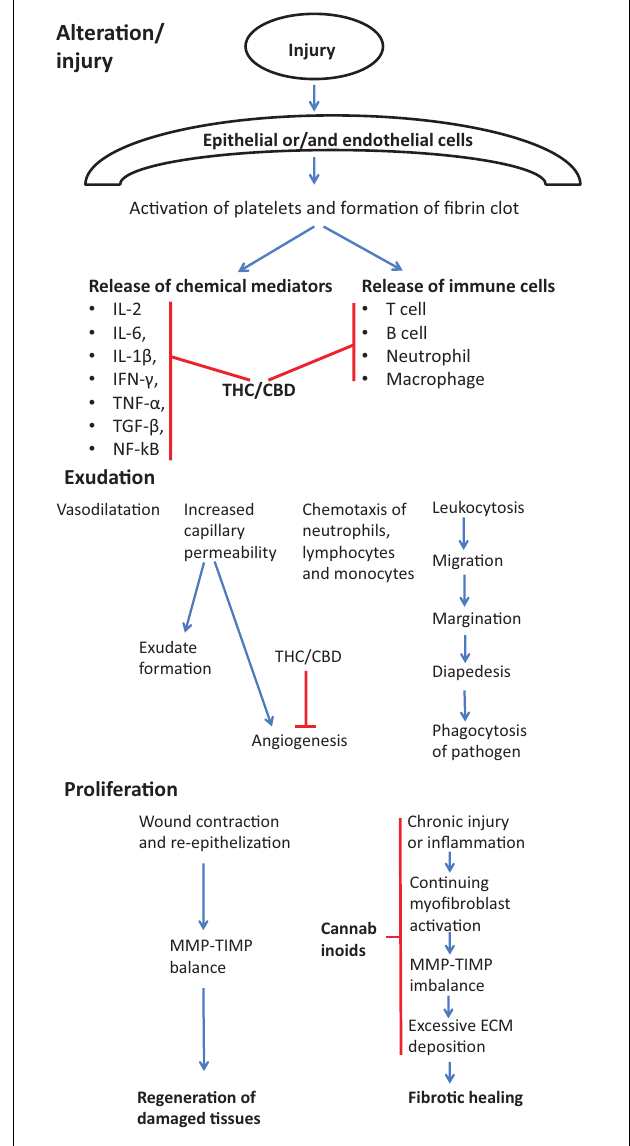
FIGURE 5 | Effect of cannabinoids on various stages of wound healing in view of preventing/treating fibrosis. During the first stage of wound healing cannabinoids are responsible for inhibiting immune response by suppressing the release of immune cells into the injury cite and by inhibiting Th1 response and main pro-inflammatory cytokines (IL-2, IL-6, IL-1 β , IFN- γ , TNF- α , TGF- β , NF-kB) (Watzl et al., 1991; Srivastava et al., 1998; Dinu et al., 2020). During exudation stage, cannabinoids inhibit the angiogenesis (Wietecha and DiPietro, 2013). Cannabinoids also actively contribute to the proliferation stage by suppressing chronic inflammation (Costa et al., 2007; Gallily et al., 2018), myofibroblast activation (Garcia-Gonzalez et al., 2009), the excessive deposition of ECM components (Garcia-Gonzalez et al., 2009) and normalization of TIMP-MMP imbalance (Garcia-Gonzalez et al.,